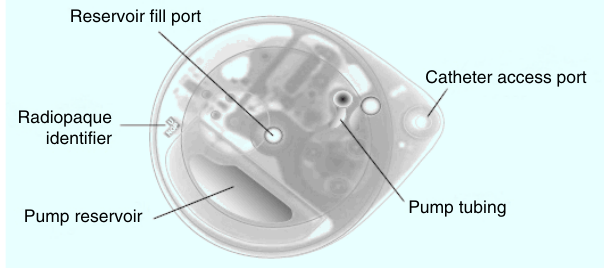
Figure 3. X-ray of the SynchroMed II Pump. The pump has 20 and 40 cc reservoirs to extend the time between refills. Drug is refilled via the reservoir fill port. Reprinted with the permission of Medtronic, Inc.©